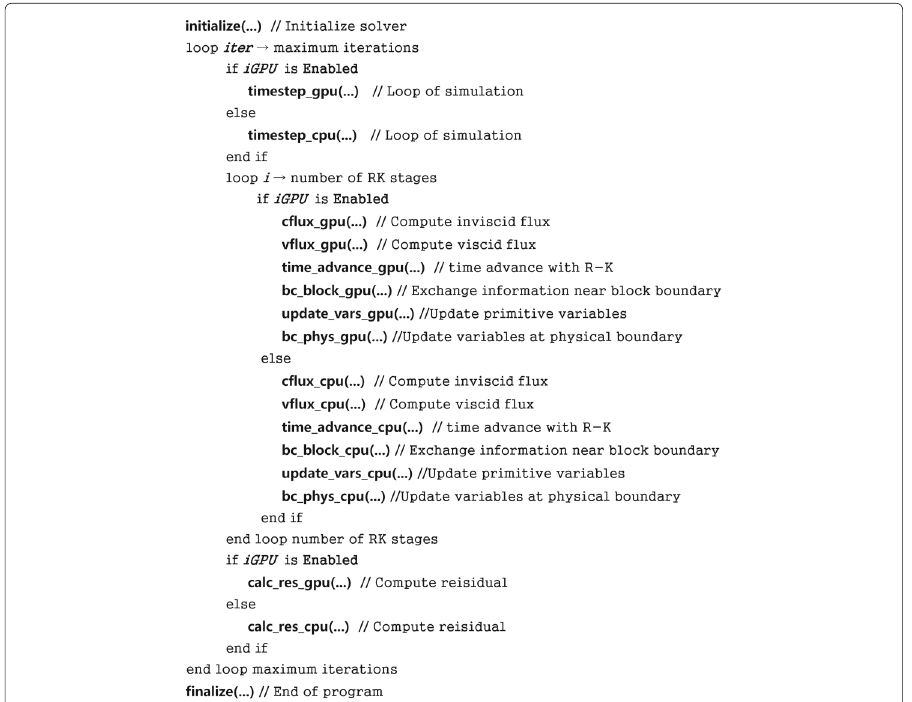
Fig. 2 Main structure of HiResX summarized by pseudo